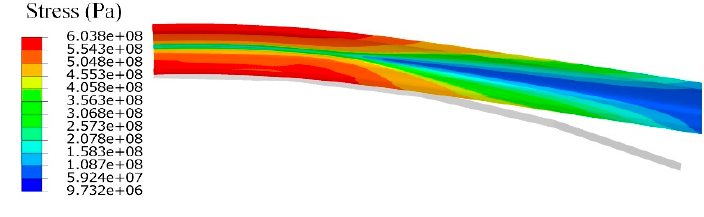
Figure 9. The stress distribution of the pipe during reeling .